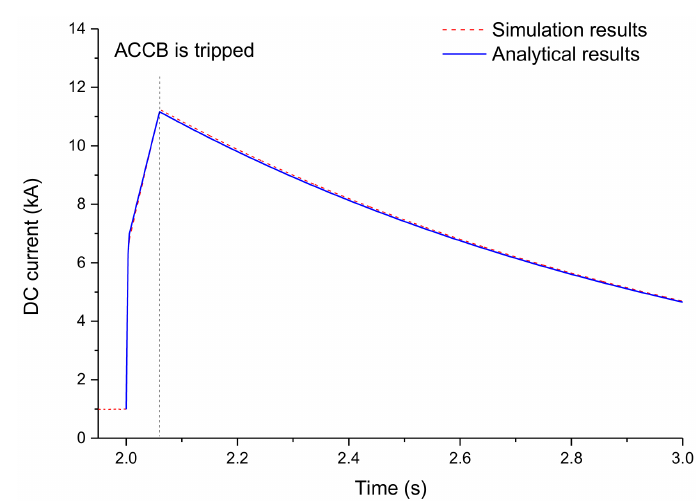
Figure 13. DC current of MMC with solution 1.